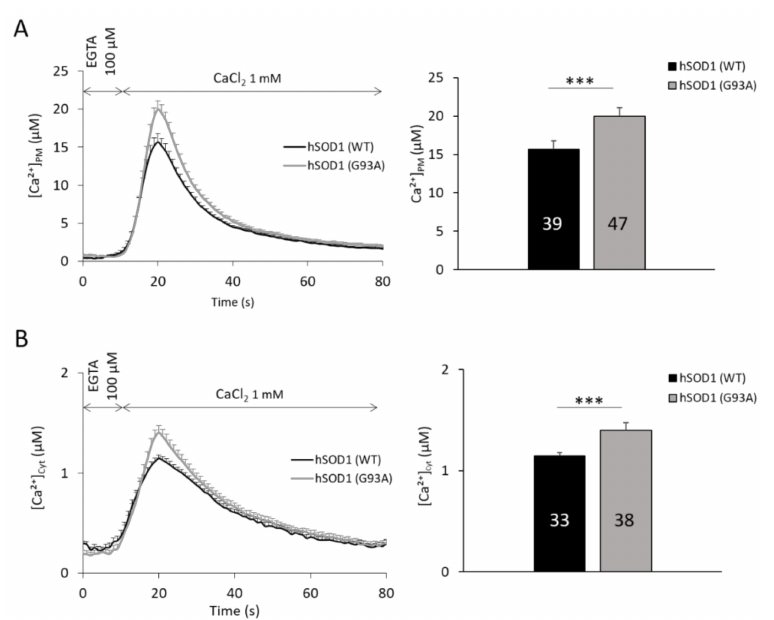
Figure 1. hSOD1(G93A) primary spinal cord astrocytes display enhanced store-operated Ca 2 + entry (SOCE) compared to controls. hSOD1(WT) (black) or hSOD1(G93A) (grey) primary spinal astrocytes were transduced with lentiviral vectors encoding AEQ PM or AEQ Cyt targeted to sub-PM microdomains or bulk cytosol, respectively, and [Ca 2 + ] PM ( A ) and [Ca 2 + ] Cyt ( B ) fluctuations were recorded after SOCE stimulation. To maximally activate SOCE, we firstly depleted intracellular Ca 2 + stores by incubating astrocytes in a Ca 2 + -free bu ff er containing EGTA (100 µ M), and then perfused cells with a CaCl 2 (1 mM)-containing solution, as indicated by arrows (see Materials and Methods for further details on the stimulation protocol). The average kinetics of the recorded local Ca 2 + transients (left panels), and the bar diagrams (right panels) reporting the corresponding [Ca 2 + ] peak values, clearly indicate that hSOD1(G93A) astrocytes have significantly higher Ca 2 + influx in both cell compartments following SOCE than hSOD1(WT)-expressing cells. Here and after, reported values are mean ± SEM, numbers inside bars indicating the number of replicates ( n ), i.e., total coverslips analyzed from at least 6 di ff erent cell cultures for each experimental condition. Peak values are in sub-PM microdomains, 15.65 ± 1.11 µ M in hSOD1(WT), 19.97 ± 1.10 µ M in hSOD1(G93A); in the cytosol, 1.15 ± 0.03 µ M in hSOD1(WT), 1.40 ± 0.07 in hSOD1(G93A). *** p < 0.001, unpaired two-tailed Student’s t